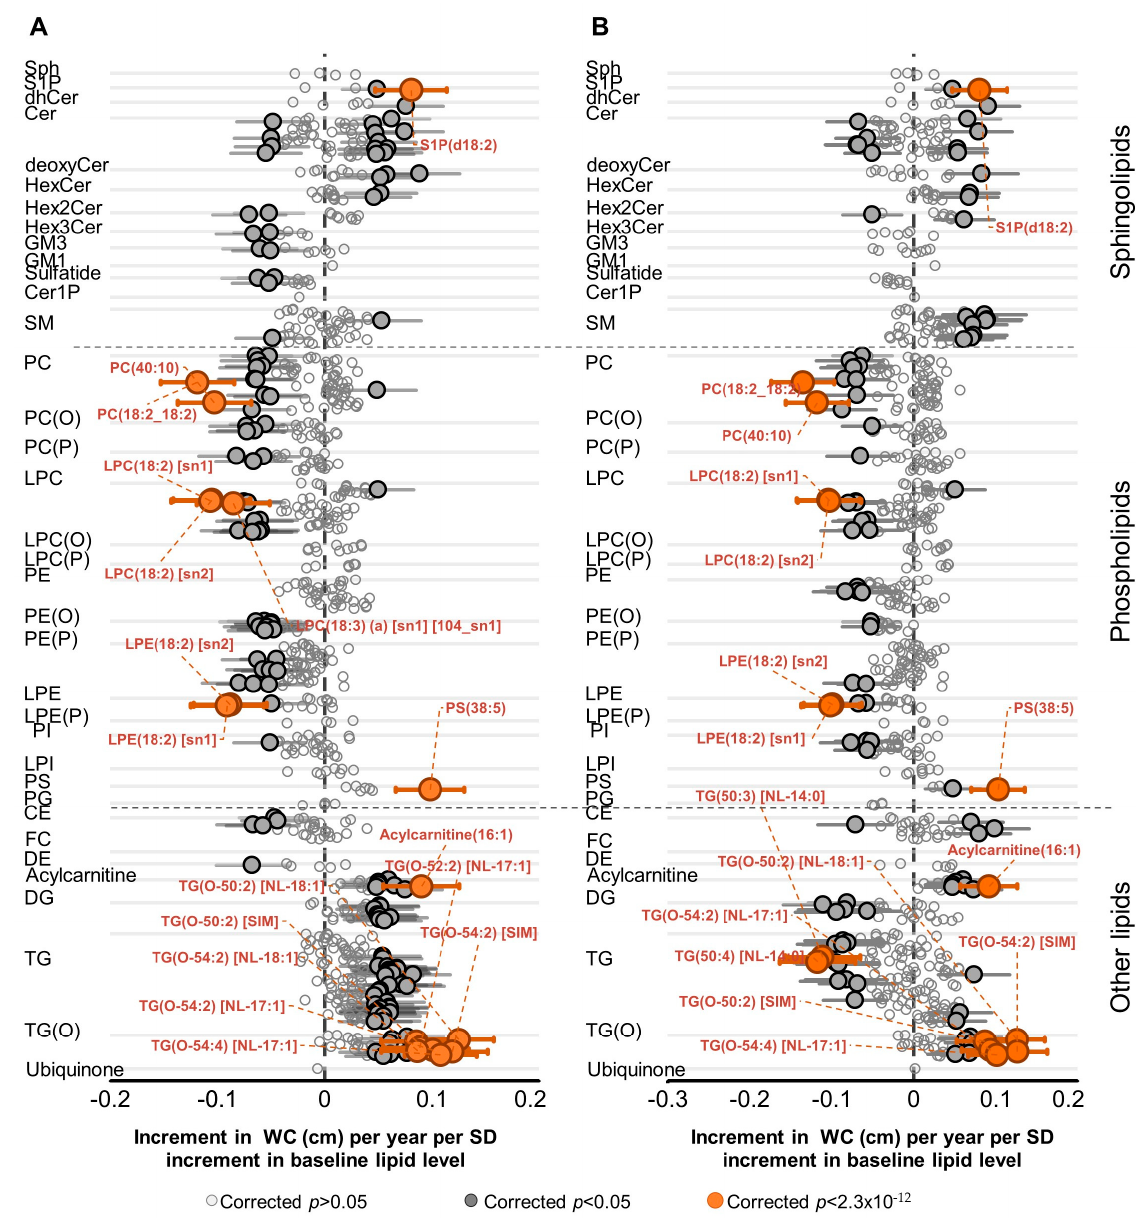
Figure 1. Association of lipid species with change in waist circumference: linear regression analyses of SD normalized lipid species against annualized change in waist circumference were performed; ( A ) adjusting for baseline age, sex and baseline WC or ( B ) for baseline age, sex, baseline WC, total cholesterol, HDL-C, triglycerides, smoking status, education, exercise time and television viewing time. The β -coefficients (95% CIs) represent the change in WC per year associated with a SD difference of the lipid species at baseline. Open circles show lipid species with corrected p > 0.05, closed circles show corrected p < 0.05 and orange circles show lipid species with the lowest corrected p -values. Whiskers represent the 95% confidence intervals. Abbreviations: CE, cholesteryl ester; Cer, ceramide; Cer-1-P, ceramide-1-phosphate; DE, dehydrocholesterol; deoxyCer, deoxyceramide; DG, diacylglycerol; dhCer, dihydroceramide; FC, free cholesterol; GM1, GM1 ganglioside; GM3, GM3 ganglioside; HDL-C,high-density lipoprotein cholesterol; HexCer, monohexosylceramide; Hex2Cer, dihexosylceramide; Hex3Cer, trihexosylceramide; LPC, lysophosphatidylcholine; LPC(O), lysoalkylphosphatidylcholine; LPC(P), lysoalkenylphosphatidylcholine; LPE, lysophosphatidylethanolamine; LPE(P), lysoalkenylphos- phatidylethanolamine; LPI, lysophosphatidylinositol; NL, neutral loss; PC, phosphatidylcholine; PC(O), alkylphosphatidyl- choline; PC(P), alkenylphosphatidylcholine; PE, phosphatidylethanolamine; PE(O), alkylphosphatidylethanolamine; PE(P), alkenylphosphatidylethanolamine; PG, phosphatidylglycerol; PI, phosphatidylinositol; SM, sphingomyelin; sn, stereospecif- ically numbered; Sph, sphingosine; S-1-P, sphingosine-1-phosphate; TG, triacylglycerol; TG(O),